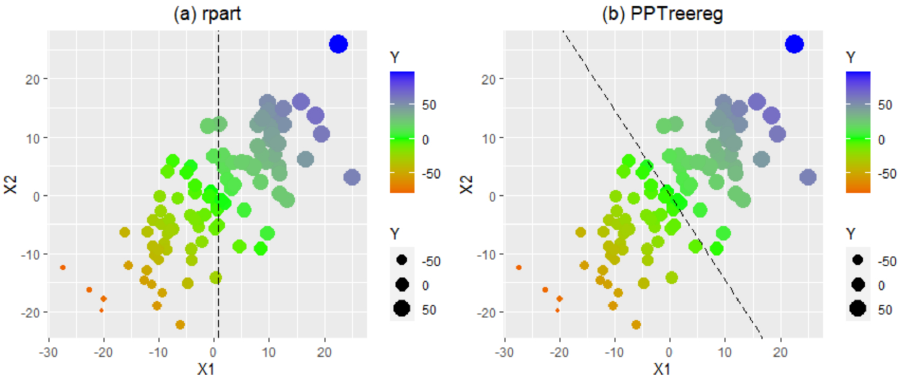
Figure 2. How to separate the space of independent variables in CART and in the projection pursuit regression tree.